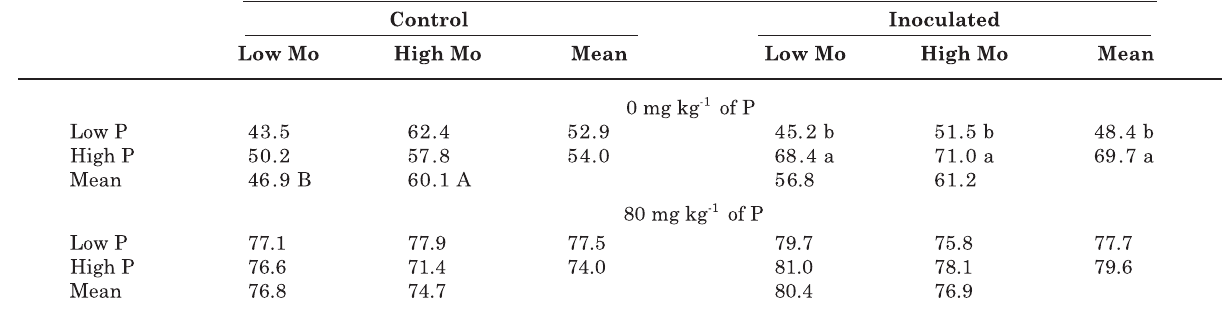
Table 4. Contribution of biological N fixation (in % of N derived from the atmosphere) in leaves of common 2 bean plants at 41 days after emergence, grown at two levels of P applied to the soil (0 and 80 mg kg -1 ) and two N sources (control without N and inoculated with rhizobia), originating from seeds with low or high P and Mo